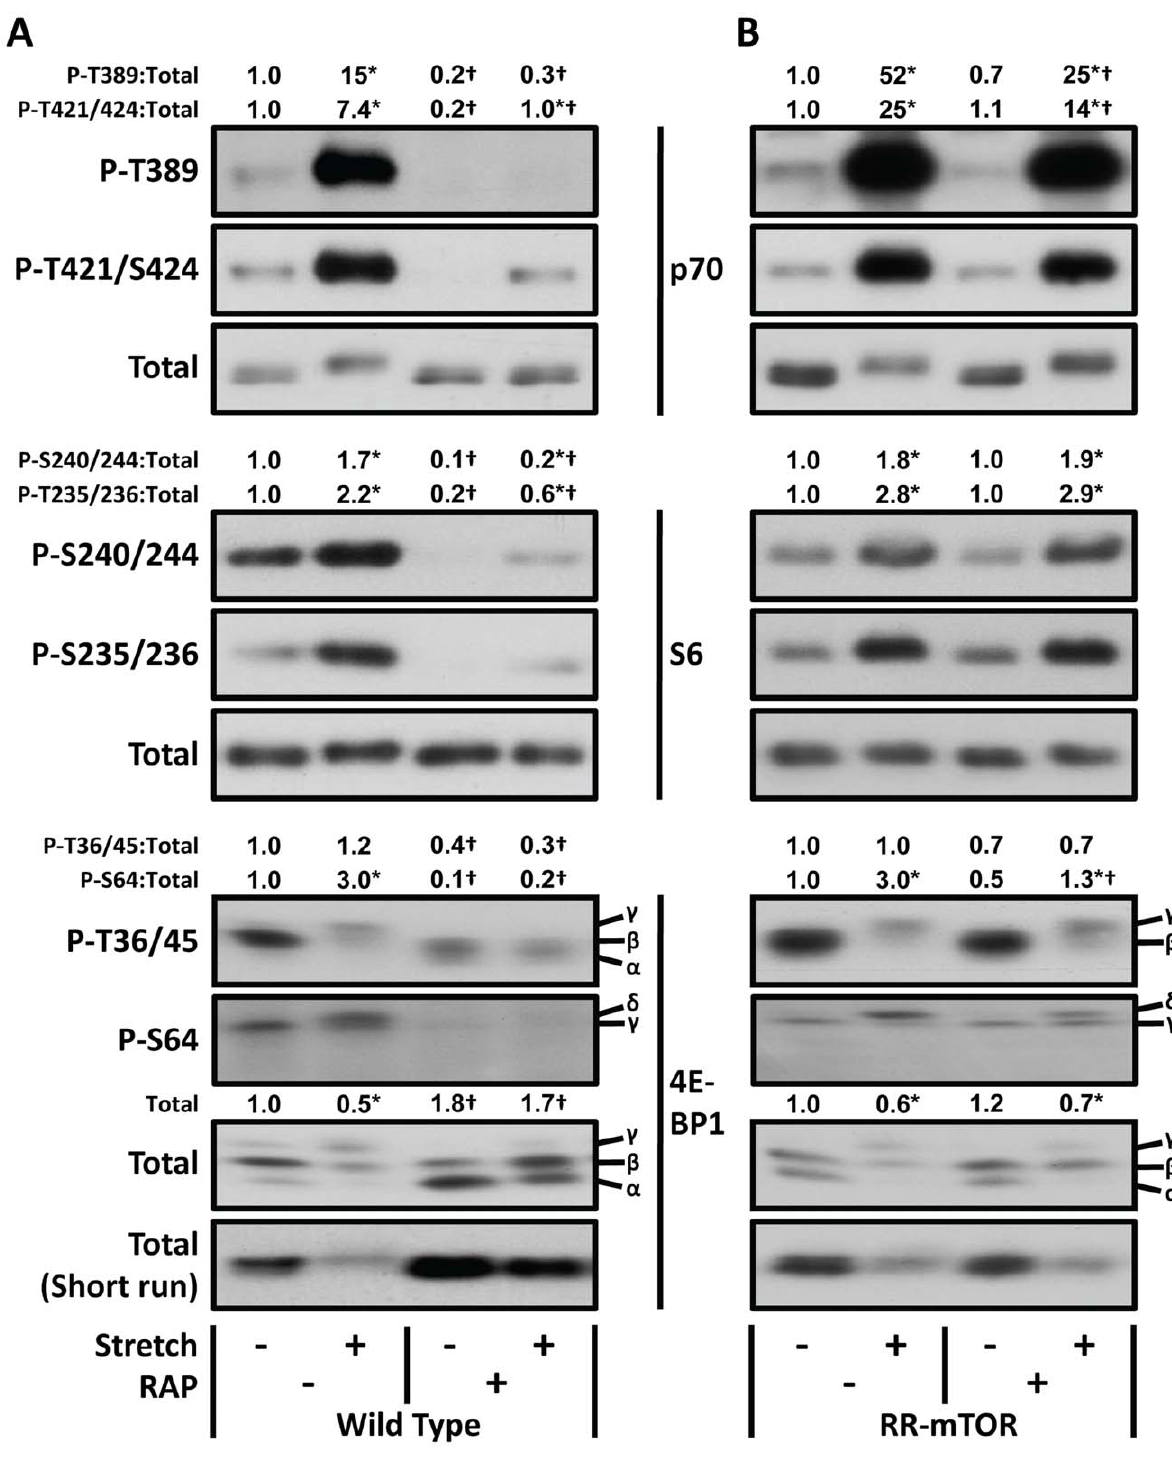
Figure 2. Validation of mTOR-dependent signaling events that are induced by mechanical stimulation. ( A ) EDL muscles from wild type mice, and ( B ) transgenic mice with muscle specific expression of a rapamycin-resistant mutant of mTOR (RR-mTOR), were held at Lo and pre- incubated with 150 nM rapamycin (RAP + ) or the vehicle (RAP –, DMSO) for 30 min. The muscles were then subjected to 90 min of stretch or control conditions followed by western blot analysis for phosphorylated (P) and total p70, S6, and 4E-BP1. The total amount, and phospho:total ratios, of each protein were measured and then expressed relative to the values obtained in the genotype-matched vehicle control samples (RAP–, Stretch–). Note: total 4E-BP1 gels were also run under conditions that minimize the gel mobility shift (short-run). All values are presented as the mean (n=3 2 5 per group). *Significantly different from the drug-matched control group, { Significantly different from the stimulation-matched vehicle group, P # 0.05.